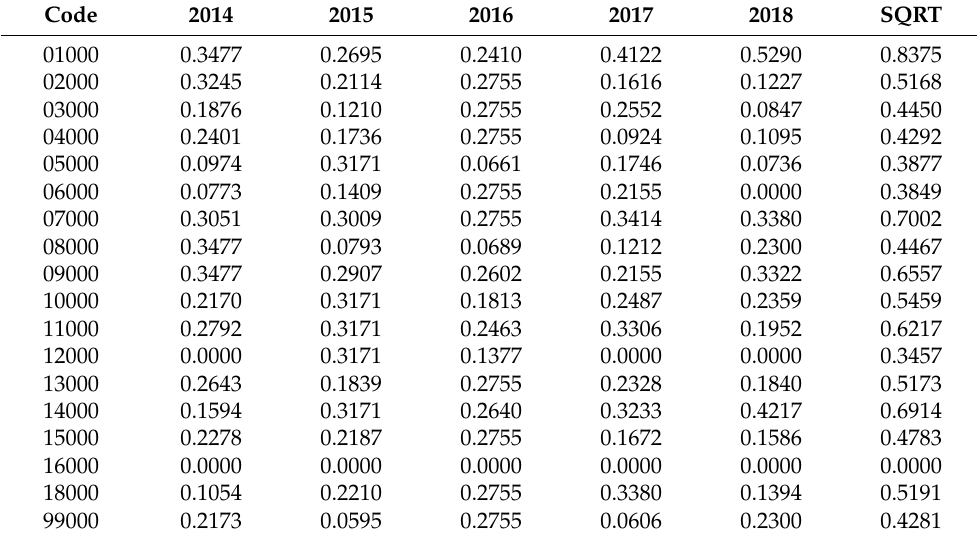
Table A11. The fourth step of TOPSIS analysis (negative ideal distance) is adopted for the deficiency data of Taiwanese